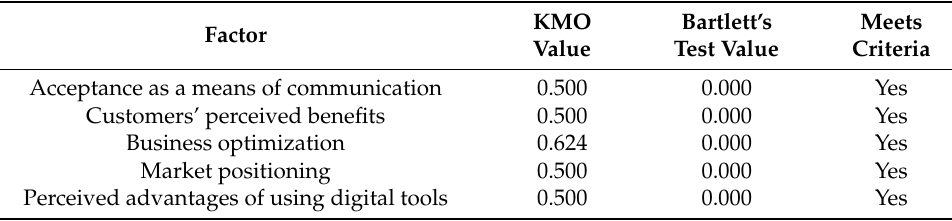
Table 4. Kaiser–Meyer–Olkin measure and Bartlett’s test of sphericity.